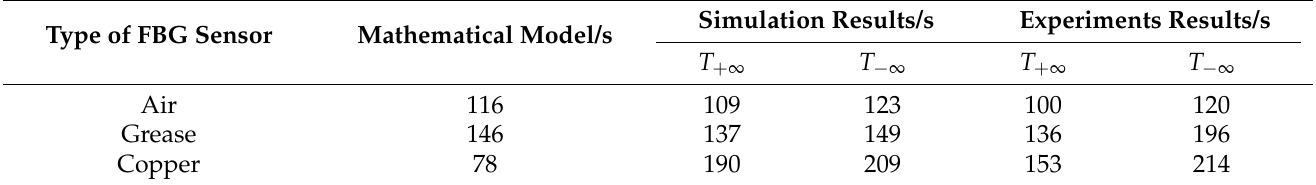
Table 2. The time constant of the sensor calculated by different research methods. Type of FBG